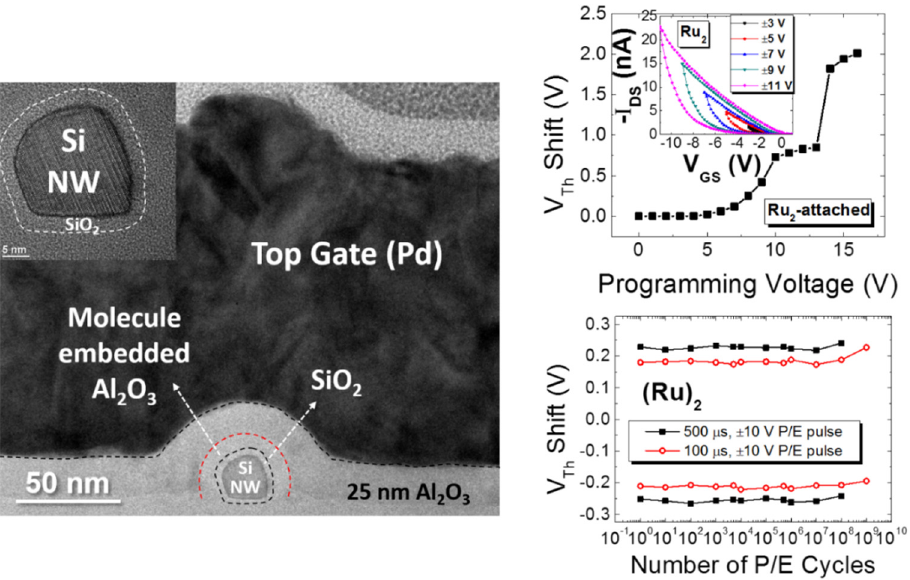
Figure 11. ( Left ) TEM image of the cross-section of a molecular flash memory device; ( Right ) discrete charging behavior of the Ru 2 molecular flash memory and the endurance properties. Reproduced with permission from [55], © American Chemical Society, 2015.